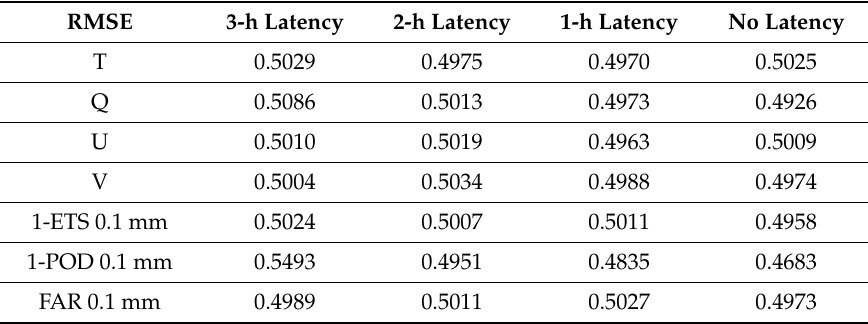
Table 4. The normalized RMSE (The Root Mean Square Errors) for T / Q / U / V and precipitation scores for the four experiments of Case I.